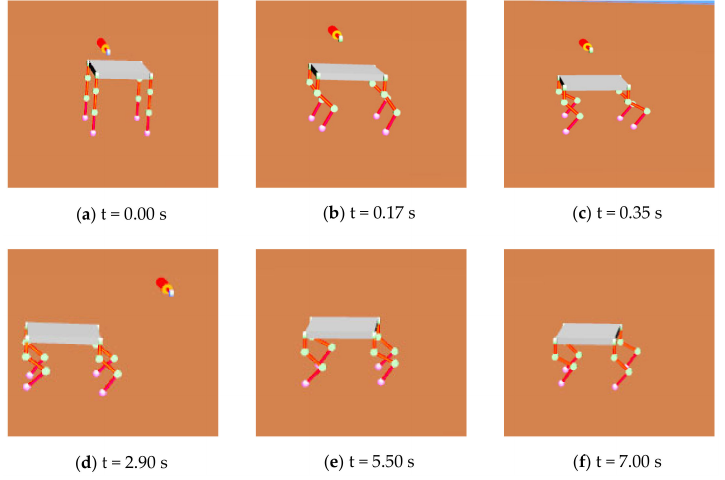
Figure 10. Simulation process of the quadruped robot walking on flat ground after adjustment strategy is added. In the beginning, the robot is in the air 50 mm away from the ground, and each joint of the robot is in position